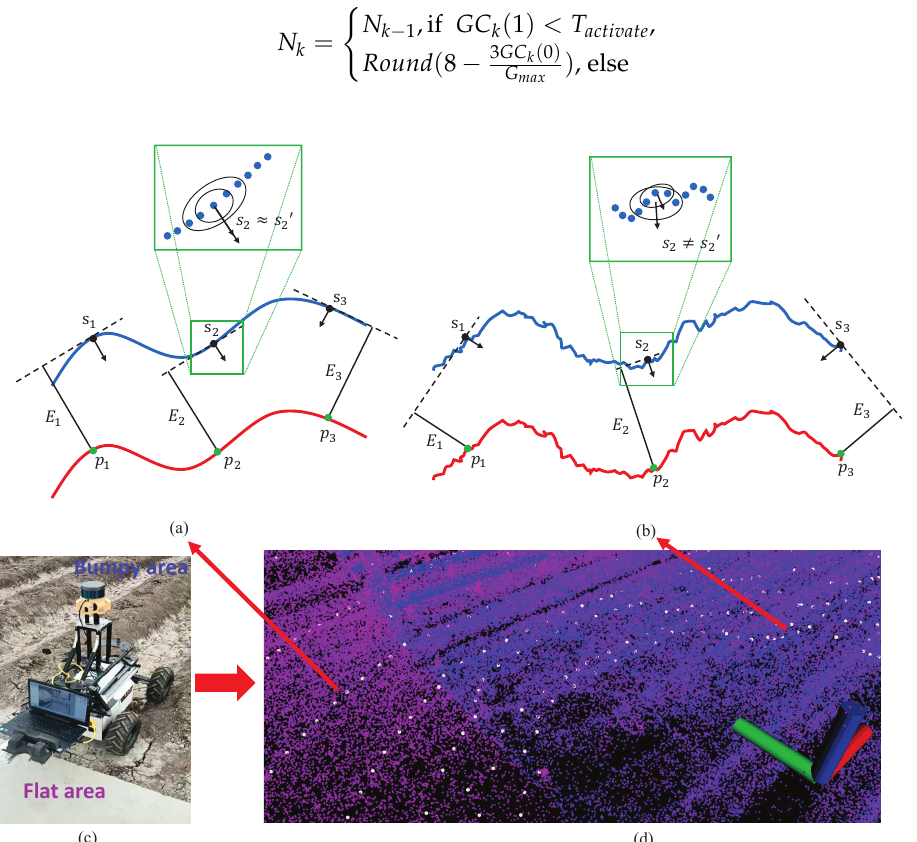
Figure 3. Point-to-plane error computation in different ground conditions. ( a ) The error computed in the ground of flat area. ( b ) The error computed in the ground of bumpy area. The blue line is the lidar points in the map, the red line is the lidar points in current lidar scan. s i is the local plane fitted by the nearest 5 map points from the point p i , and s i (cid:48) is fitted by 3 points. E i is the associated point-to-plane error represented as the length of the related black line. The enlarged drawing at the top highlights the local plane fitted by the map points of different numbers. ( c ) The picture of real-world ground condition containing the planar area and bumpy area. ( d ) The related current lidar points and the surrounding local map points of picture ( c ), where the pink points and the blue points correspond to the map points in the flat area and bumpy area, respectively, and the white points are the lidar points in the current